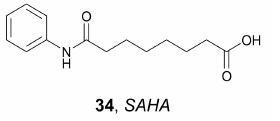
Figure 16. Chemical structure of SAHA 34 .